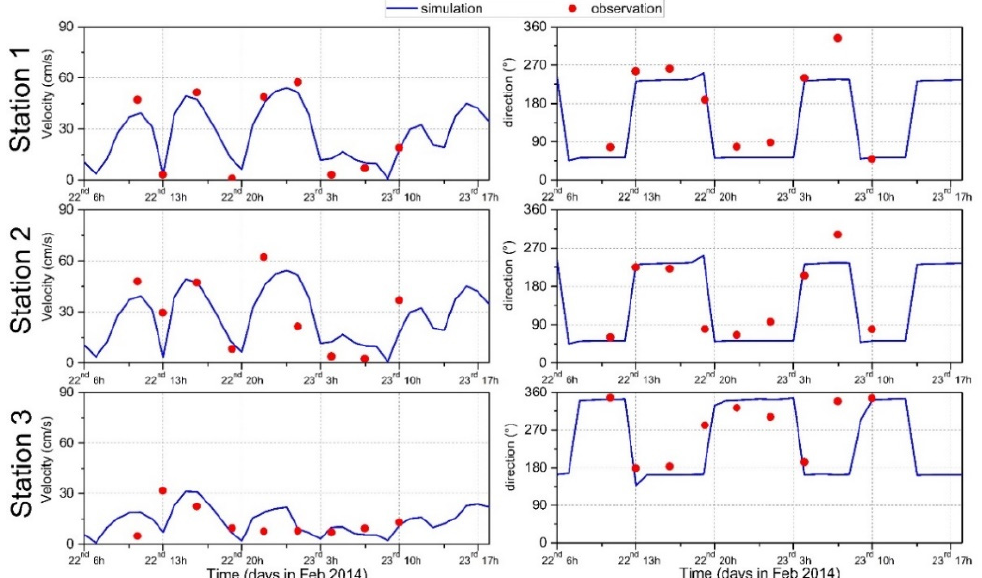
Figure 2. Comparison of simulated and observed velocity at three stations (see Figure 1 for loca ‐